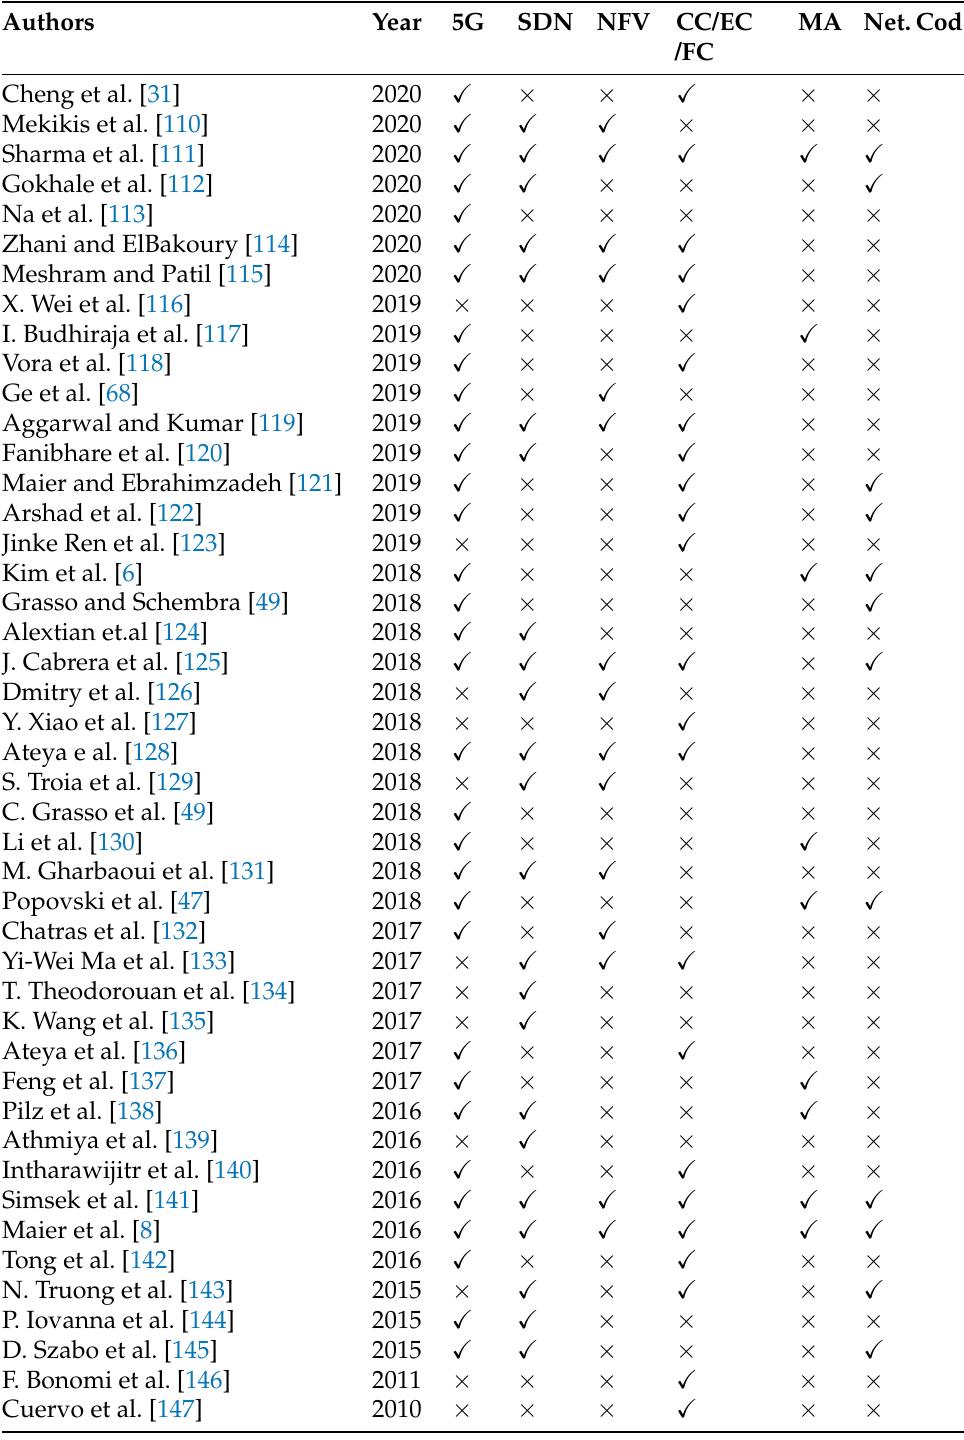
Table 5. Review of related articles on TI for enabling technologies (5G, SDN, NFV, Cloud/Edge/Fog Computing (CC/EC/FC), Multiple Access (MA), and Network Coding (Net.